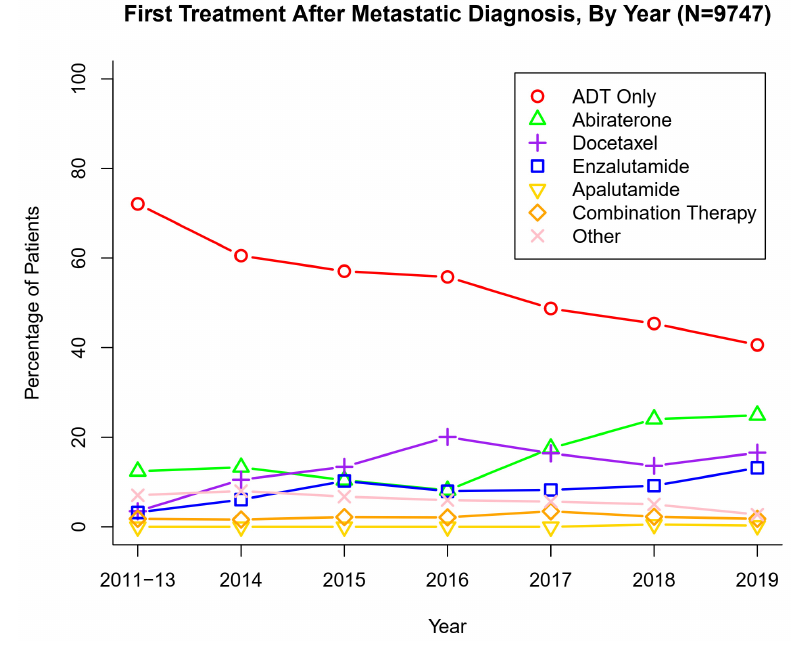
Figure 3. First Treatment After Metastatic Diagnosis, By Year ( N = 9747).